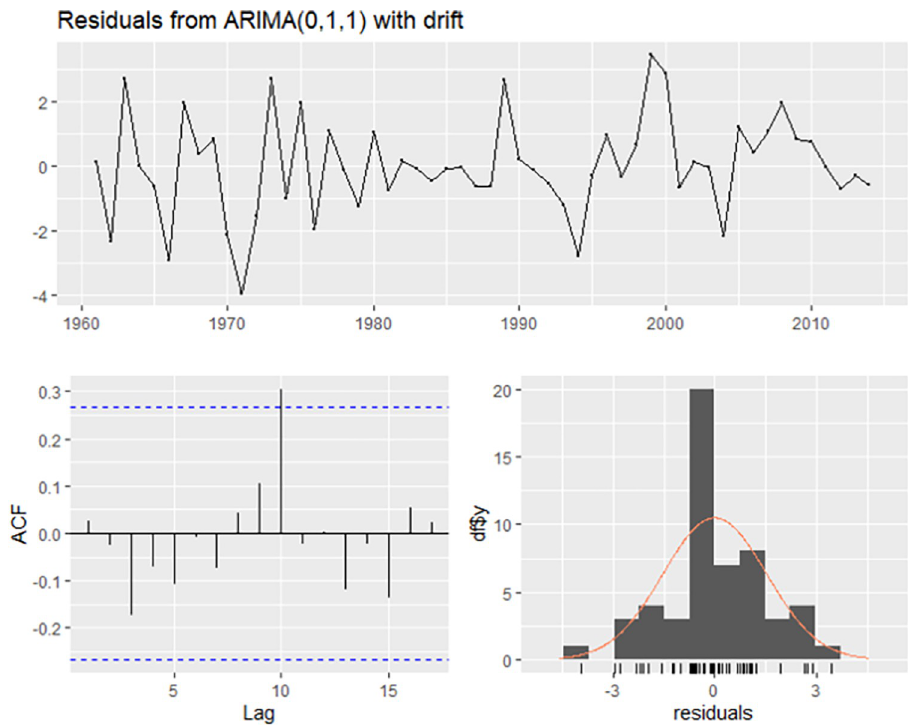
Fig 7. A time series plot of the residuals with corresponding ACF diagram, and a histogram for the ARIMA (0,1,1) model with drift. ACF, autocorrelation function; ARIMA, autoregressive integrated moving average.